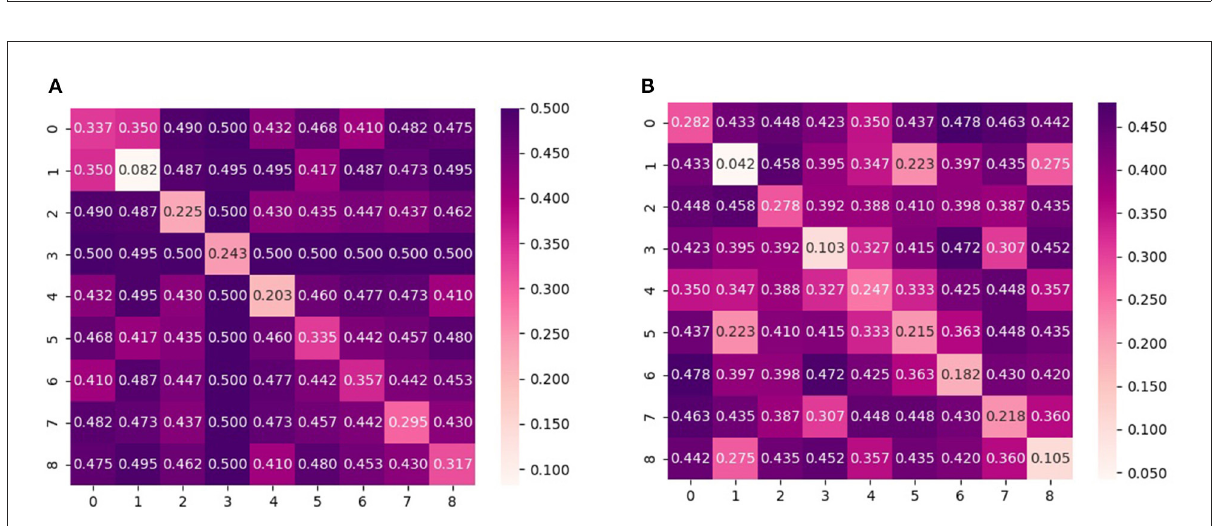
FIGURE4 Pair-wise cross-subject conditional shift with non-normalized and whitened features computed from subjects that performed physical activity on the bike . (A) No normalization. (B) Z-score normalization.